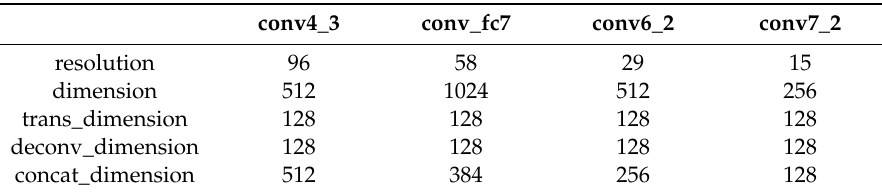
Table 1. MSF_SSD Network Top Four Feature